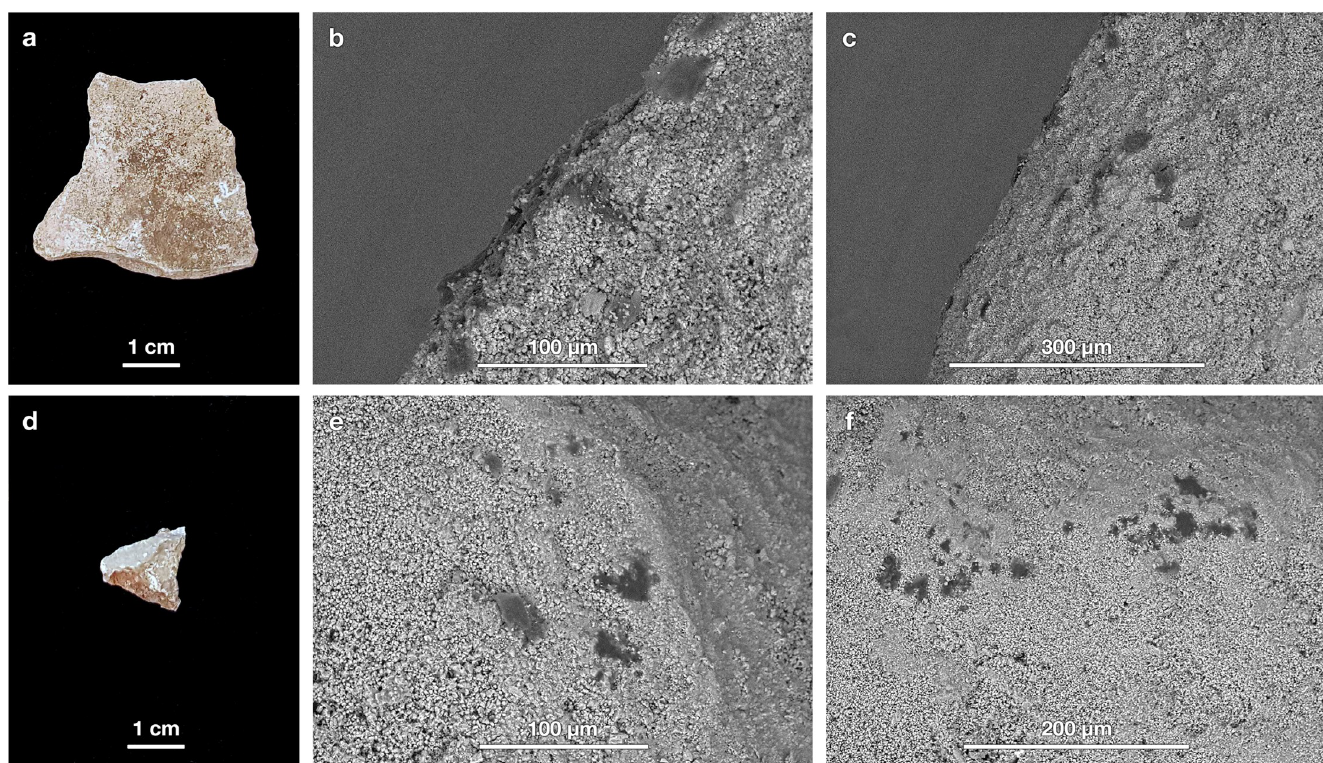
Fig 14. Example artifact and geofact. (a) An unretouched distal fragment of a limestone flake and (d) an unmodified stone from sediment packet P88-216 both exhibit the presence of microscopic organic residues in SEM images (b, c, e, f).